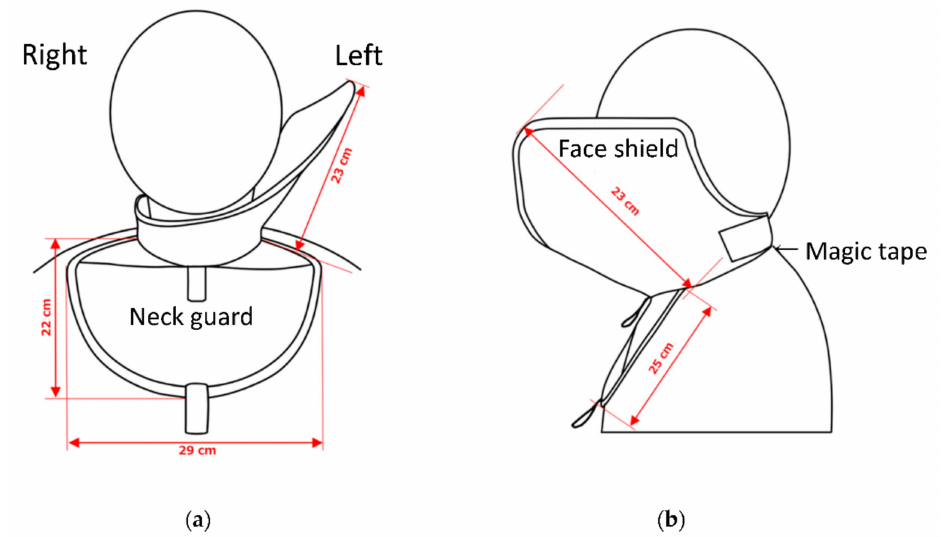
Figure 2. Schematic of the novel shield: ( a ) frontal view; ( b ) lateral view. The novel shield consists of a neck guard and face shield, which together comprise a single unit to promote stability and prevent misalignment. The shield is firmly attached behind the neck of the IVR physicians using Velcro to protect them from scattered radiation from the left side. The device consists of a neck guard and face shield designed using a 0.25 mm Pb-equivalent rubber sheet (nonlead protective sheet).